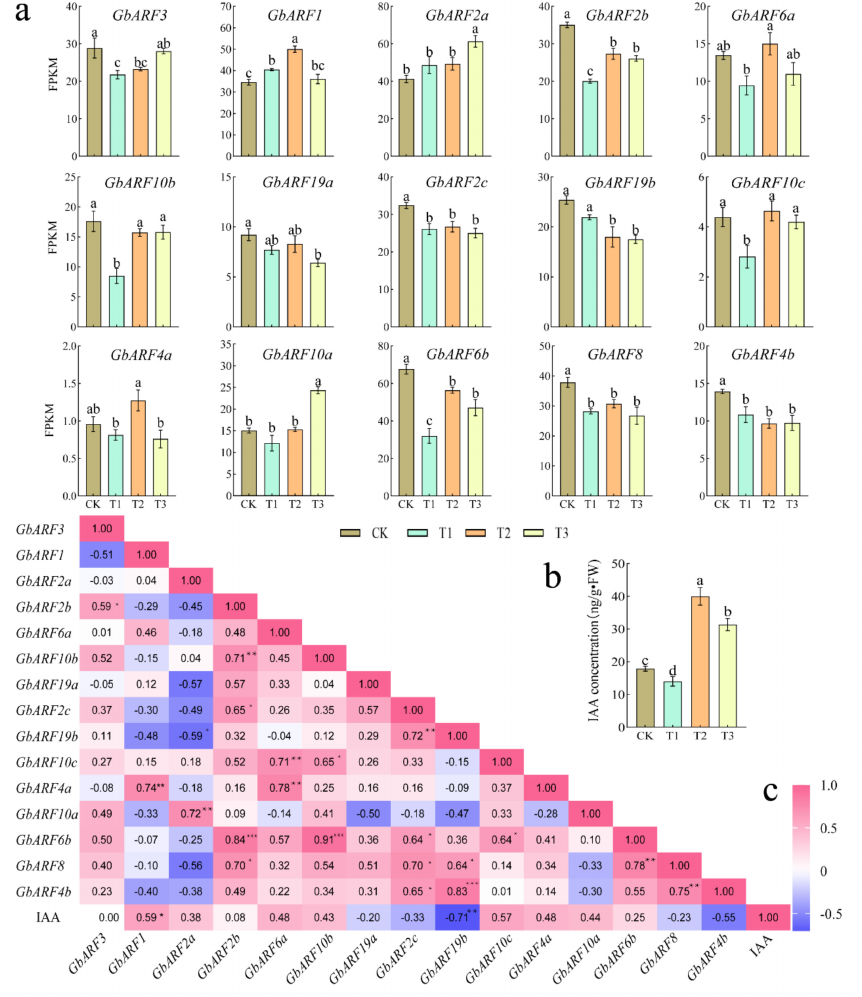
Figure 9. Expression profiles of GbARFs and the correlation with IAA concentration under SA treatment. ( a ) FPKM values of GbARFs ( b ) IAA Concentration. ( c ) Correlation heat map in GbARFs expression level and IAA response to SA. FPKM values were showed as mean means ± standard error (SE). CK, T1, T2 and T3 in ( a ) represent exogenous SA concentration of 0, 1, 2 and 3 mmol/L, respectively. Letters in Figure ( a , b ) represent significant differences at the 0.05 level, and * in Figure ( c ) means the 0.05 significant level, ** means the 0.01 level, and *** means the 0.001